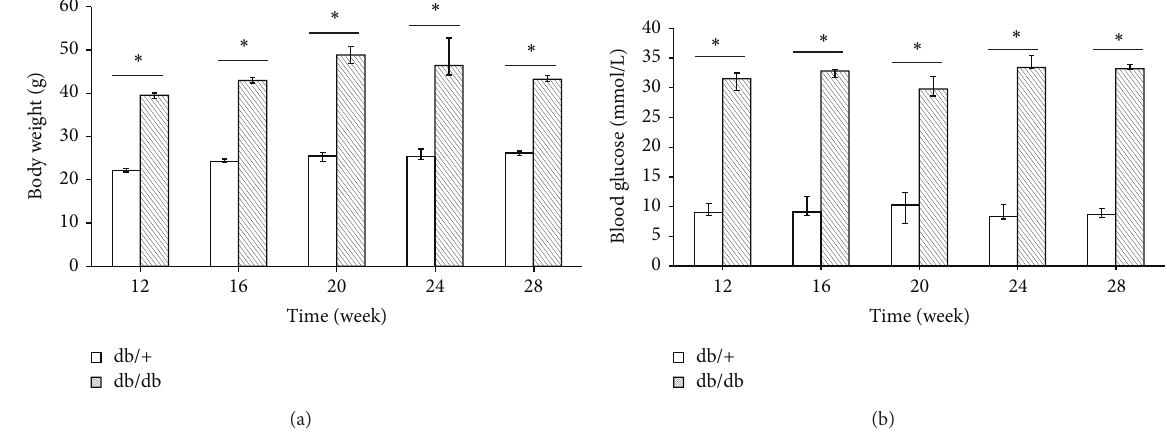
Figure 1: Diabetic mice (db/db) underwent a high body weight (a) and high blood glucose (b) compared to nondiabetic mice (db/+) at 12, 16, 20, 24, and 28 weeks. ∗ 𝑃 < 0.01